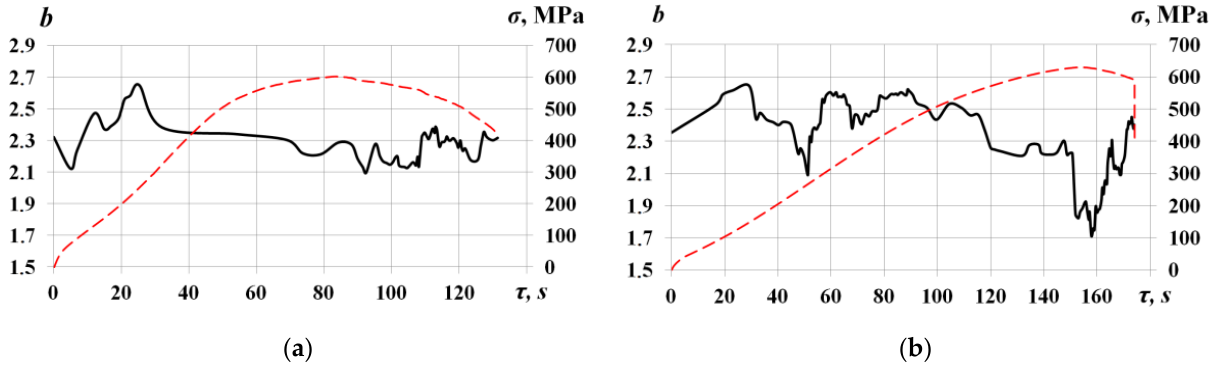
Figure 7. Time dependences of the “ b-value ” parameter with the superimposed stress curve, for specimens with a thickness of 1 mm ( a ) and 6 mm ( b ).